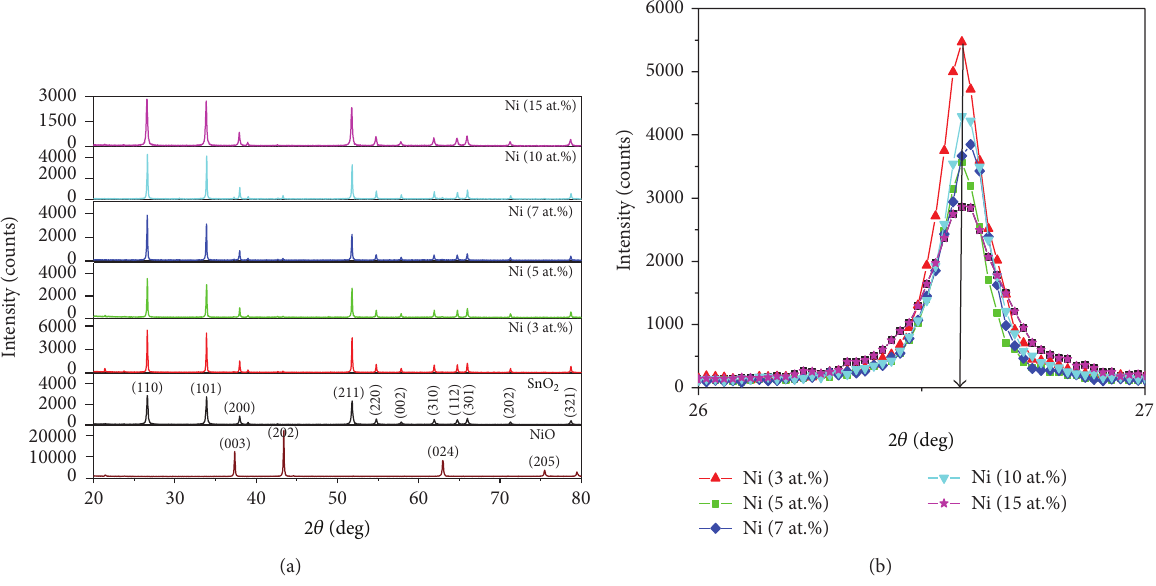
Figure 1: (a) X-ray diffraction patterns of Pure NiO, SnO 2 , and Ni doped SnO 2 powder samples at different Ni doping concentrations. (b) XRD patterns of Ni doped SnO 2 powder samples in 2 𝜃 range of 26 ∘ -27 ∘